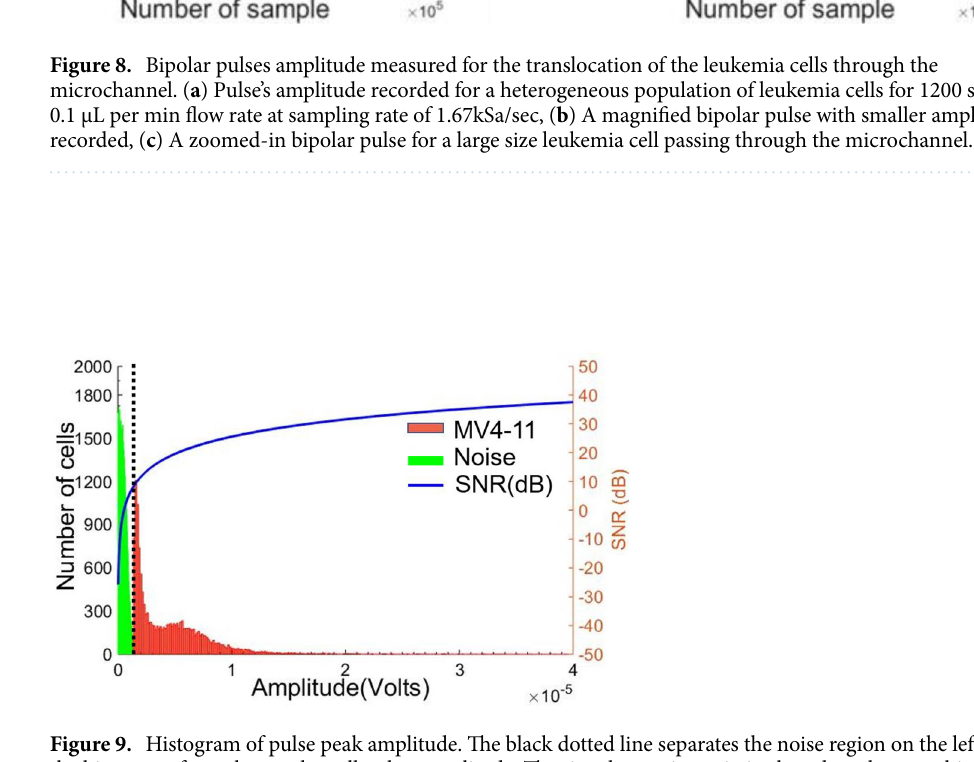
Figure 9. Histogram of pulse peak amplitude. The black dotted line separates the noise region on the left side of the histogram from the regular cell pulses amplitude. The signal-to-noise ratio is plotted on the same histogram by calculating the root-mean-square (rms) value of the pulse amplitude and the standard deviation of noise for 50,000